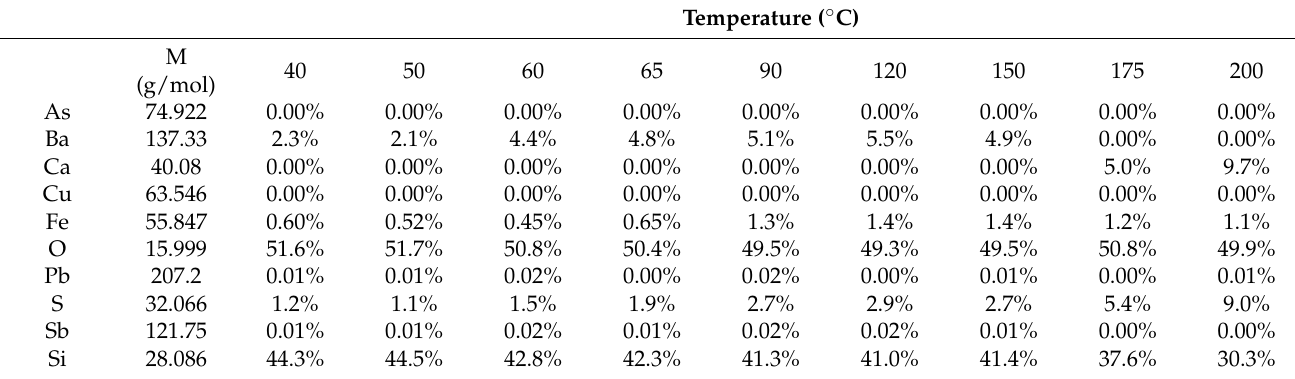
Table 11. Results of first thermodynamic modelling in weight percentage.